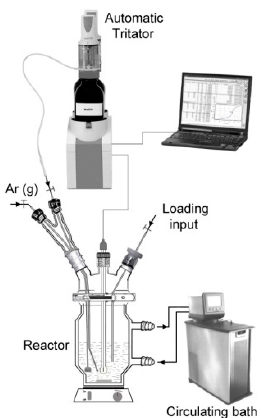
Figure 4. Representation of the devices for the titrimetry of the lipase-catalyzed hydrolysis of the five tetraester substrates employed in this work; the T-shapes indicate sealing valves. All reagents were added to the reactor through the loading input.